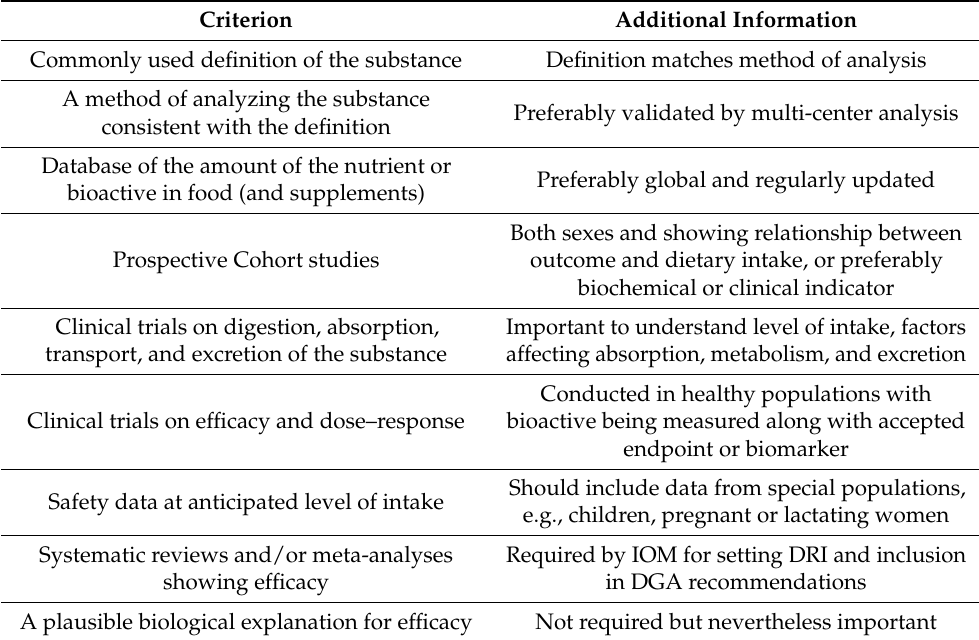
Table 2. Criteria to qualify for DRI evaluation and inclusion in DGAs. Adapted from